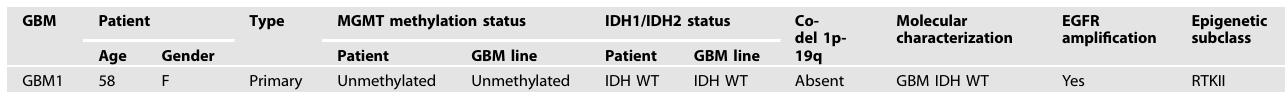
(Early Apoptosis):3.9% ± 0.5; AV + /PI + (Late Apoptosis):15.6% ± 1.4; Cell Death Discovery (2022)